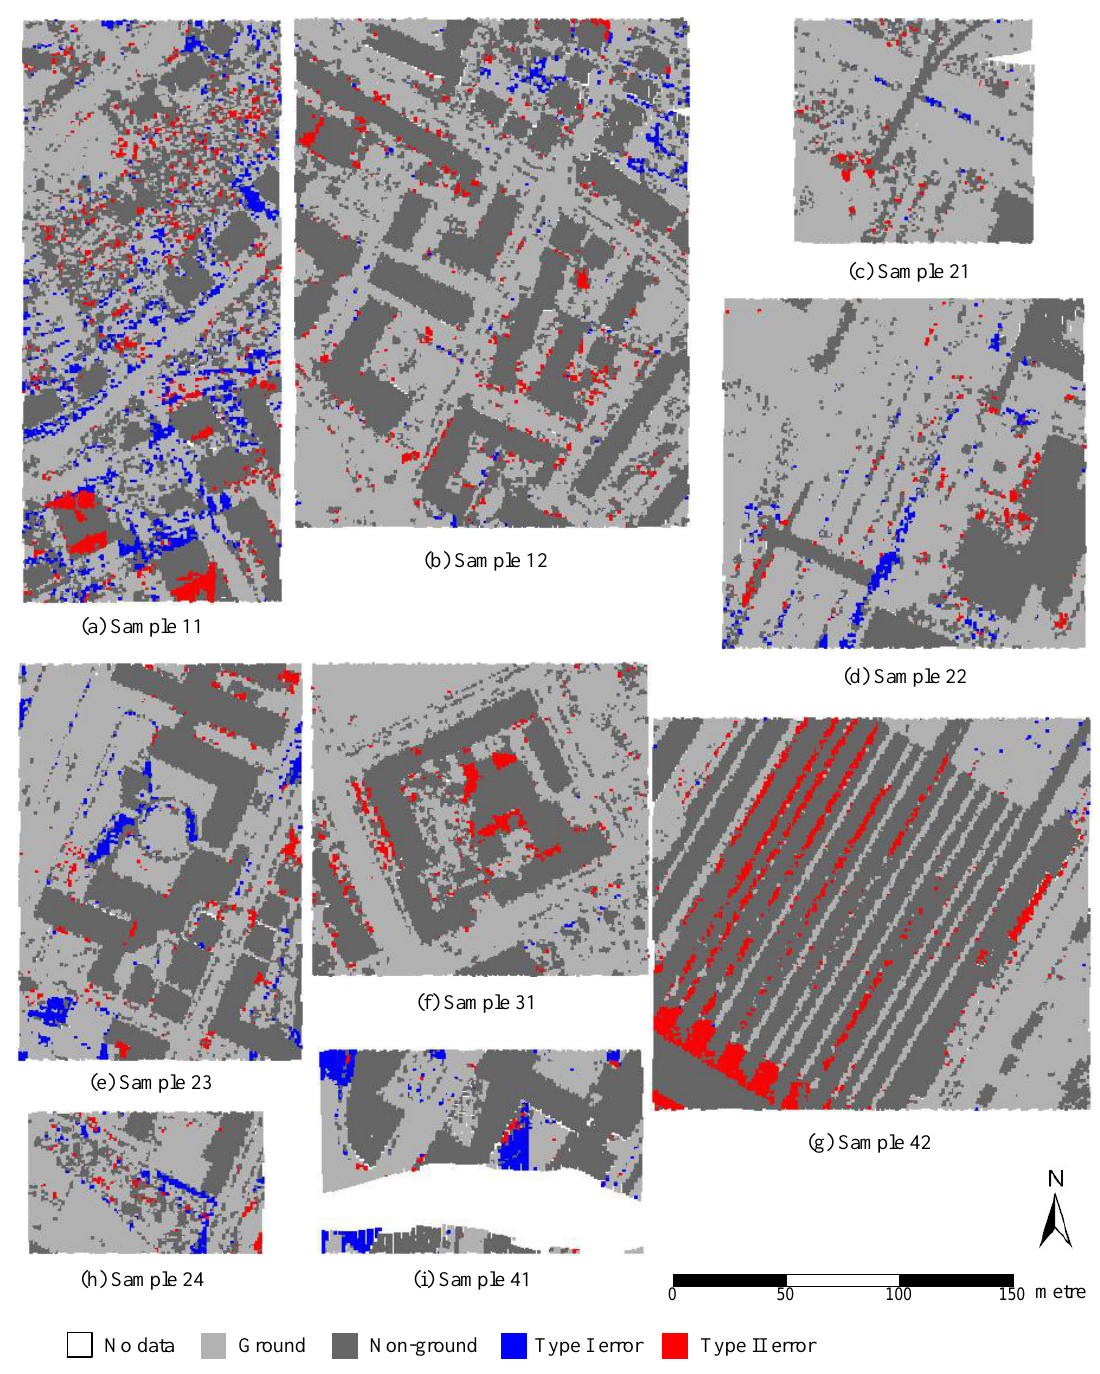
Figure 11. Error distribution of filtering urban samples 11–42 of ISPRS data.